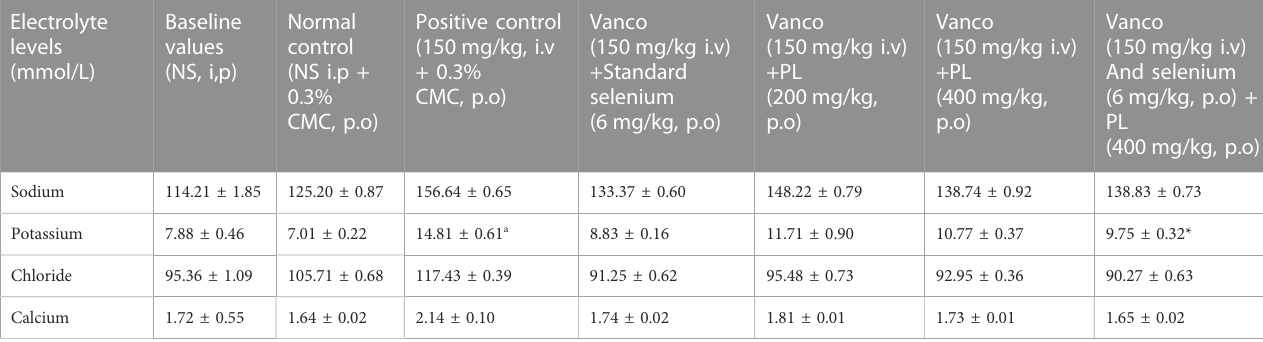
TABLE 4 Effect of preventive administration of PL and selenium on blood electrolyte levels in rats treated with vancomycin. Electrolyte levels